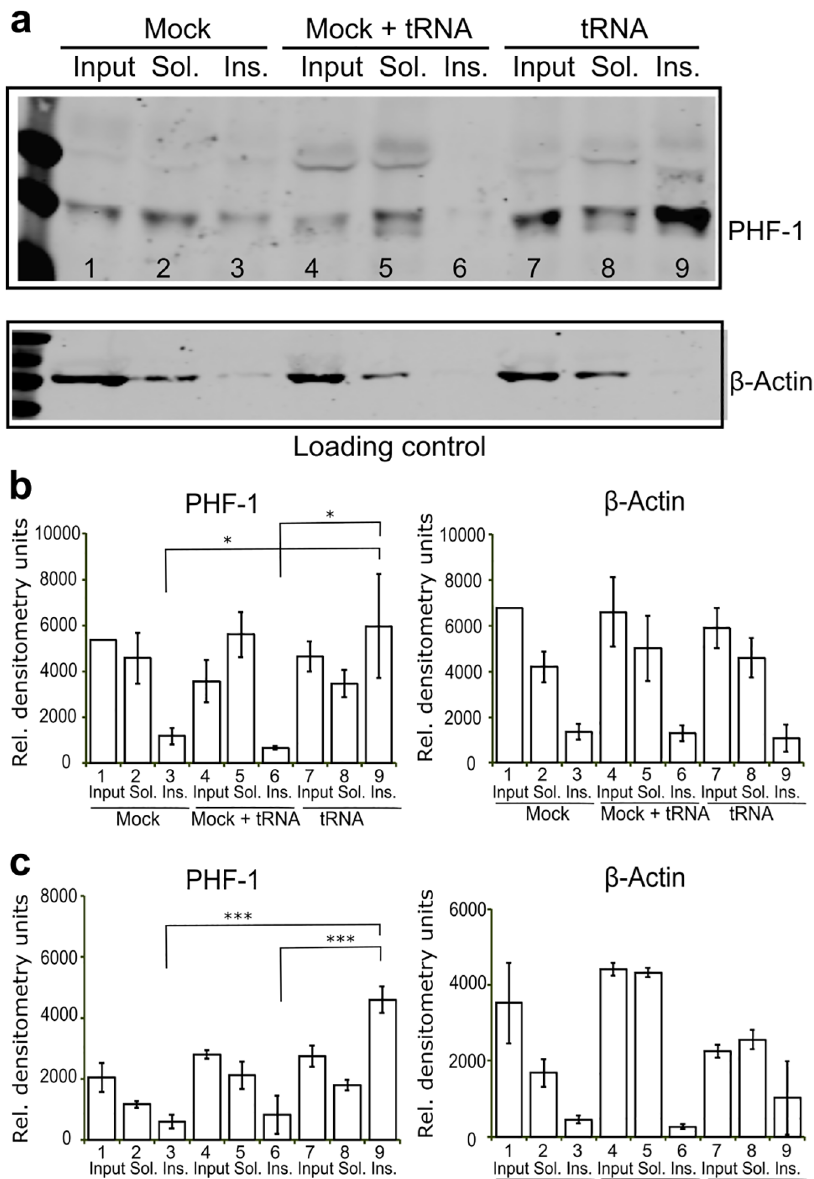
Fig 7. tRNA transfection accumulates sarkosylinsoluble tau in human-induced pluripotent stem cell (hiPSC) derived neurons. (A) Representative western blot of neuronsharboringa P301L tau mutation transfected with tRNA, but not cells transfected in the absenceof nucleicacids (Mock) present evidencefor accumulation of sarkosyl insolubletau (Ins.) as seen in the intenseband in lane 9 labeledwith PHF-1 antibody. Additionof tRNA to the lysis buffer is insufficientto increasethe tau present in the insolublefractions (compareMock + tRNA, lane 6 to tRNA, lane 9). (B-C) Quantificationof PHF-1 tau and β -actinlevel for both neuronsharboringa P301L tau mutation (B) and neuronsexpressing wild type tau (C) are shown. Error bar represents standard error of the mean. * p < 0.05, *** p < 0.001, n > 3. The numerical data used in B and C are includedin S1